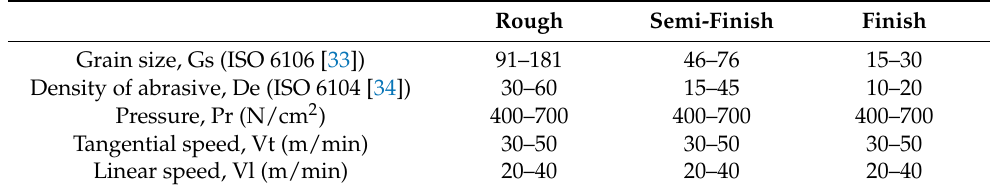
Table 1. Low and high levels for the different variables employed in the rough, semi-finish and finish experiments. Rough Semi-Finish Finish Grain size, Gs (ISO 6106 [33]) 91–181 46–76 15–30 Density of abrasive, De (ISO 6104 [34])